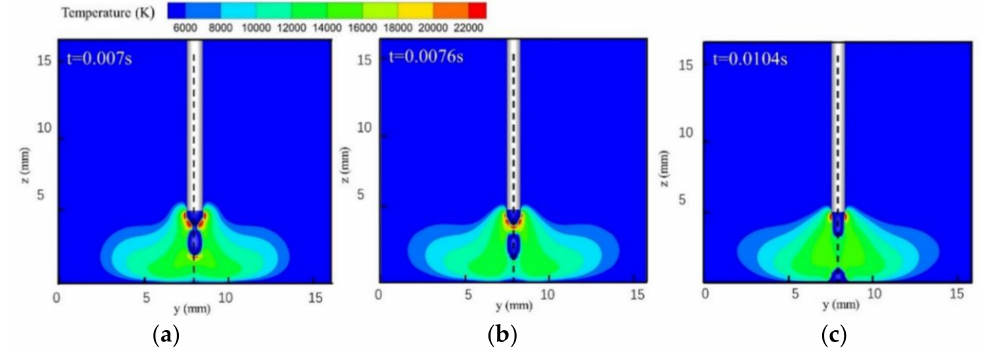
Figure 2. Single-MIG arc temperature distribution: ( a ) t = 0.007 s; ( b ) t = 0.0076 s; ( c ) t = 0.0104 s.